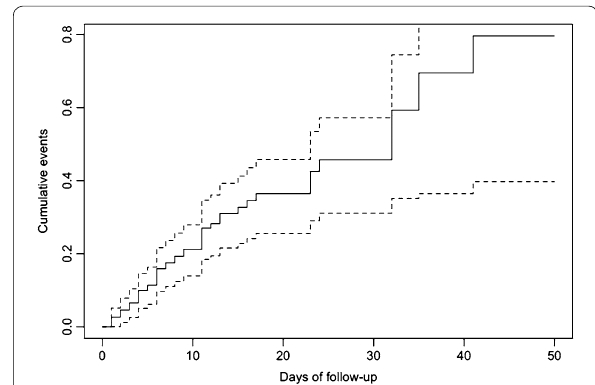
Fig. 2 Kaplan–Meier curve of cumulative thromboembolic events in the cohort. We decided to include all patients presenting even with early diagnosis of DVT (within 48 h) as none of them had known risk factors (past medical history of DVT, or family history, cancer, obesity), nor any symptoms identified before admission. They were severely injured patients and had either extended vehicle extrication time or